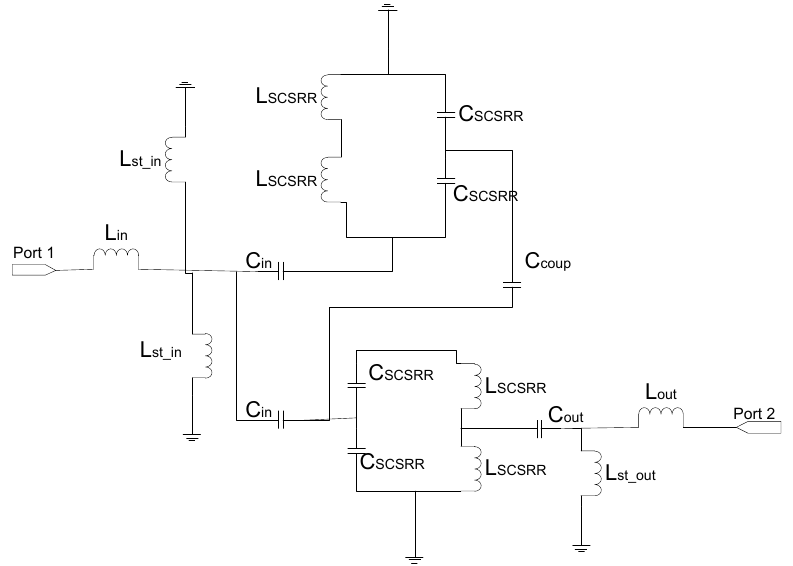
Figure 12. Equivalent circuit for the stripline multilayer resonator.